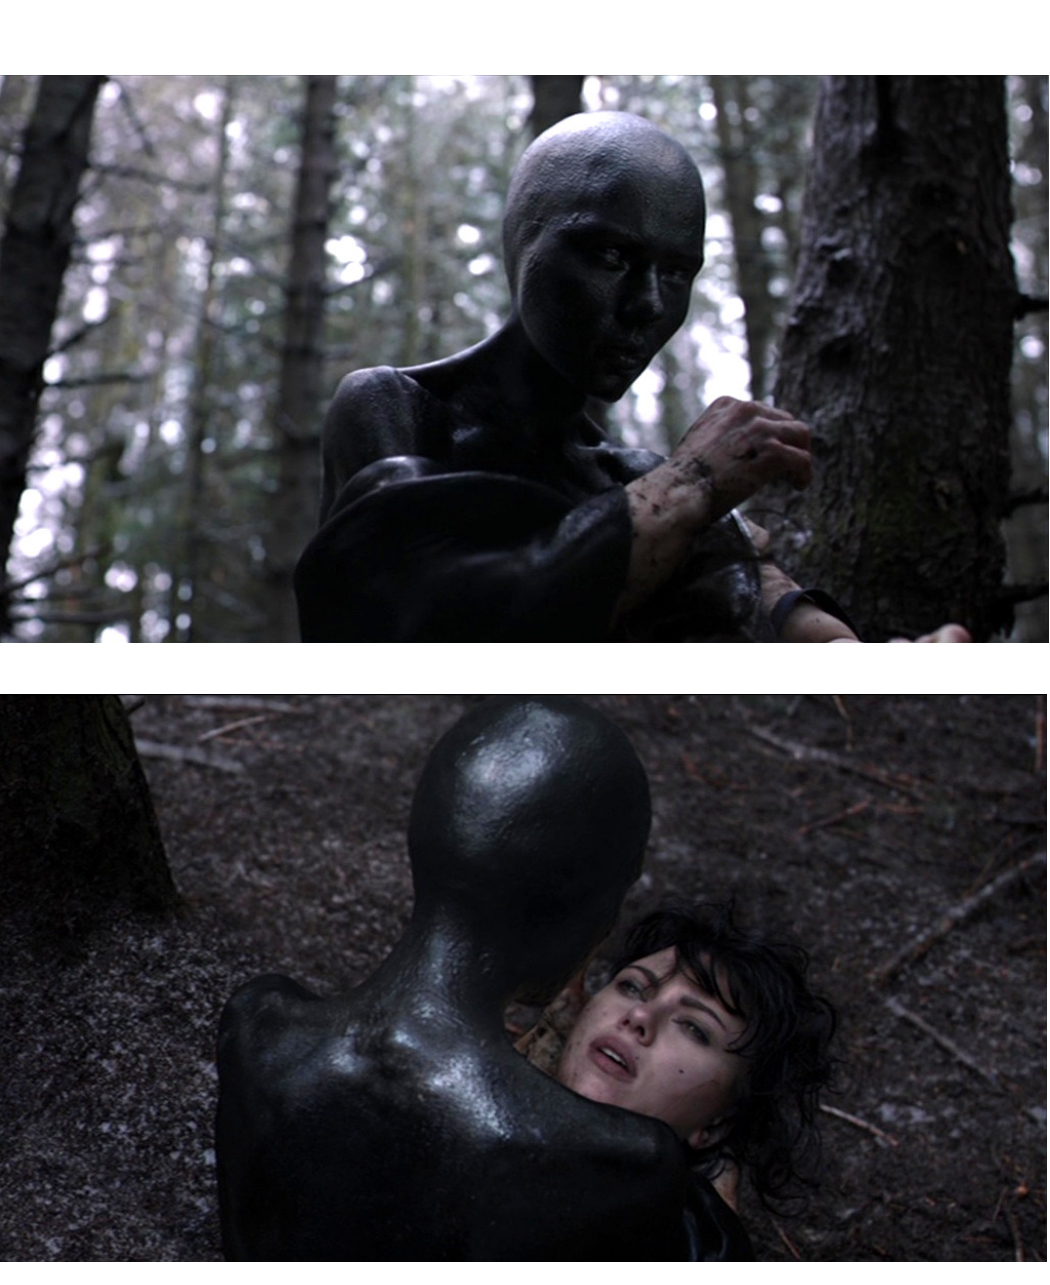
Figure 5: Under the Skin directed by Jonathan Glazer. 2013; London: BFI & Film 4.